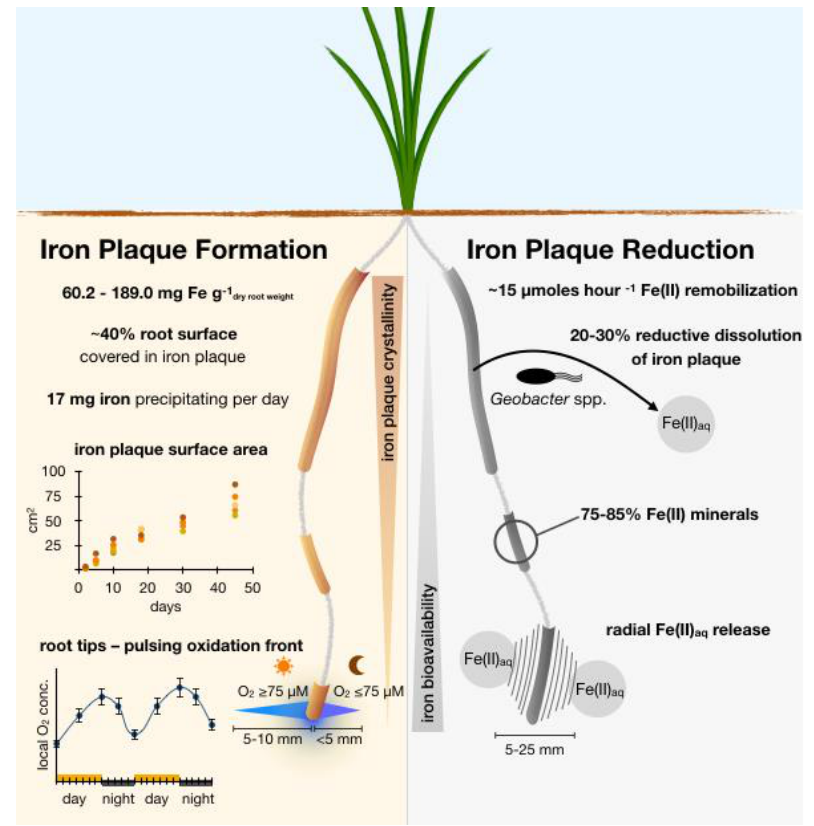
Figure 7. Summary of biogeochemical processes observed in this study that affect the rhizosphere iron cycle at and around rice roots covered in root iron plaque. ( Left ): Oxidative side of the outlined rhizosphere iron cycle with estimates for an immobilization of iron per gram dry weight rice root, root iron plaque coverage, and diurnal changes in ROL at root tips that affect local redox conditions. ( Right ): Reductive side of the proposed rhizosphere iron cycle with observed rates and extent for root iron plaque remobilization through reductive dissolution and reductive mineral transformation by the Geobacter spp. culture used in the current study, a ff ecting iron plaque crystallinity and bioavailability,